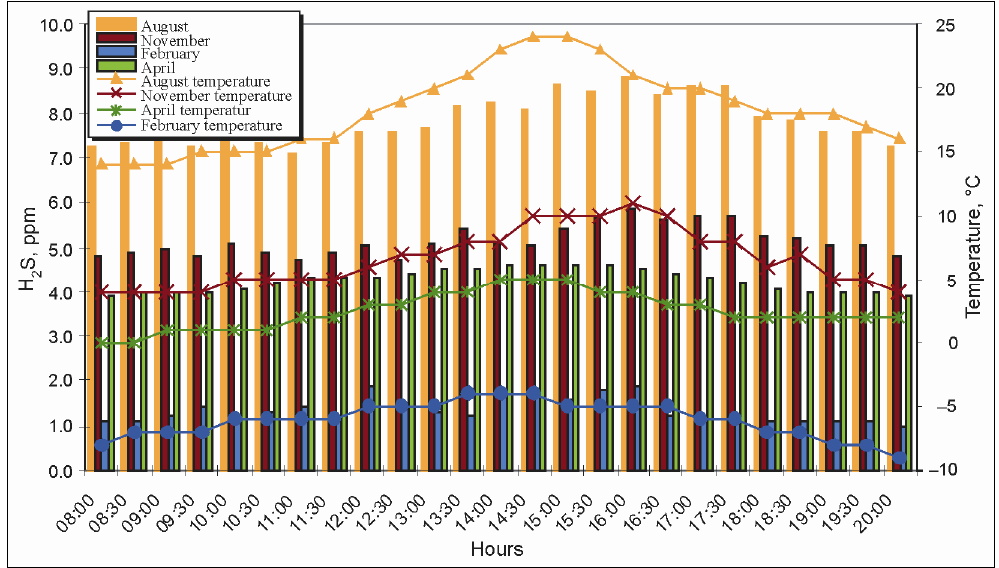
Fig. 10. H 2 S change during the day (point No. 9)